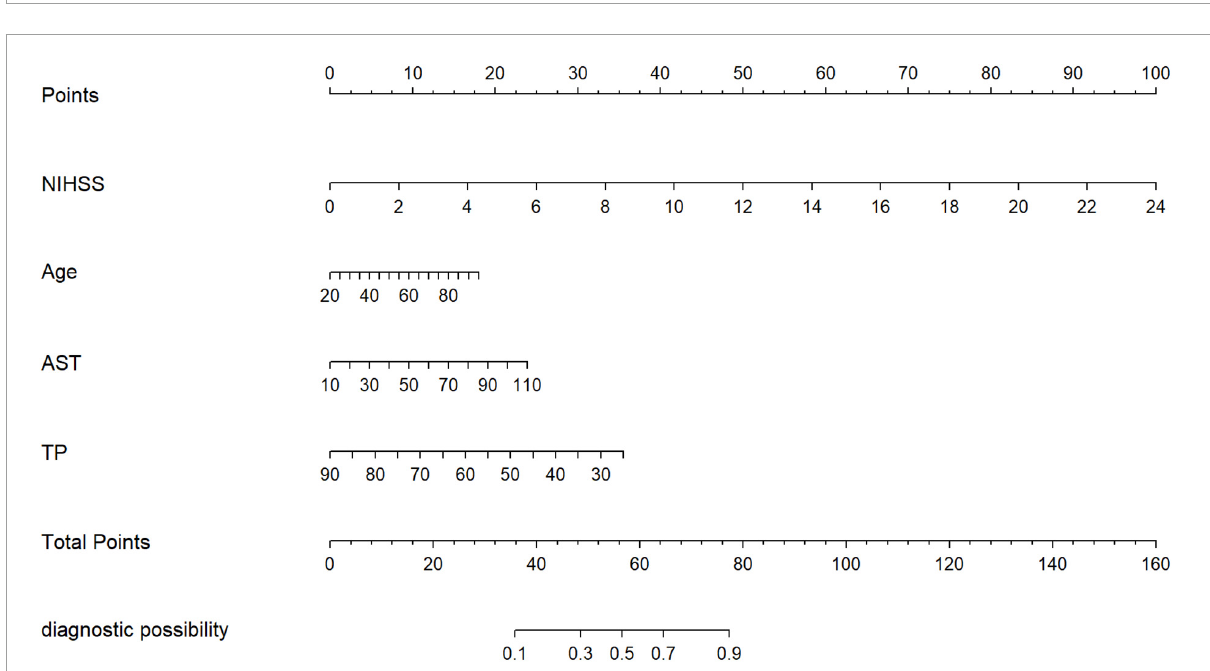
FIGURE3 The nomogram for patients with non-CE-type AIS. To use the nomogram, an individual patient’s value is located on each variable axis, and a line is drawn upward to determine the number of points received for each variable value. The sum of these numbers is located on the total points axis, and a line is drawn downward to the survival axes to determine the likelihood of the poor outcomes.